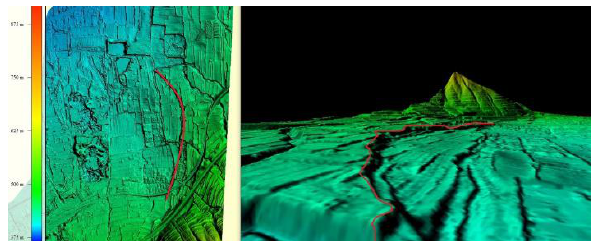
Figure 9. Location and three-dimensional view of a fault in front of Huashan